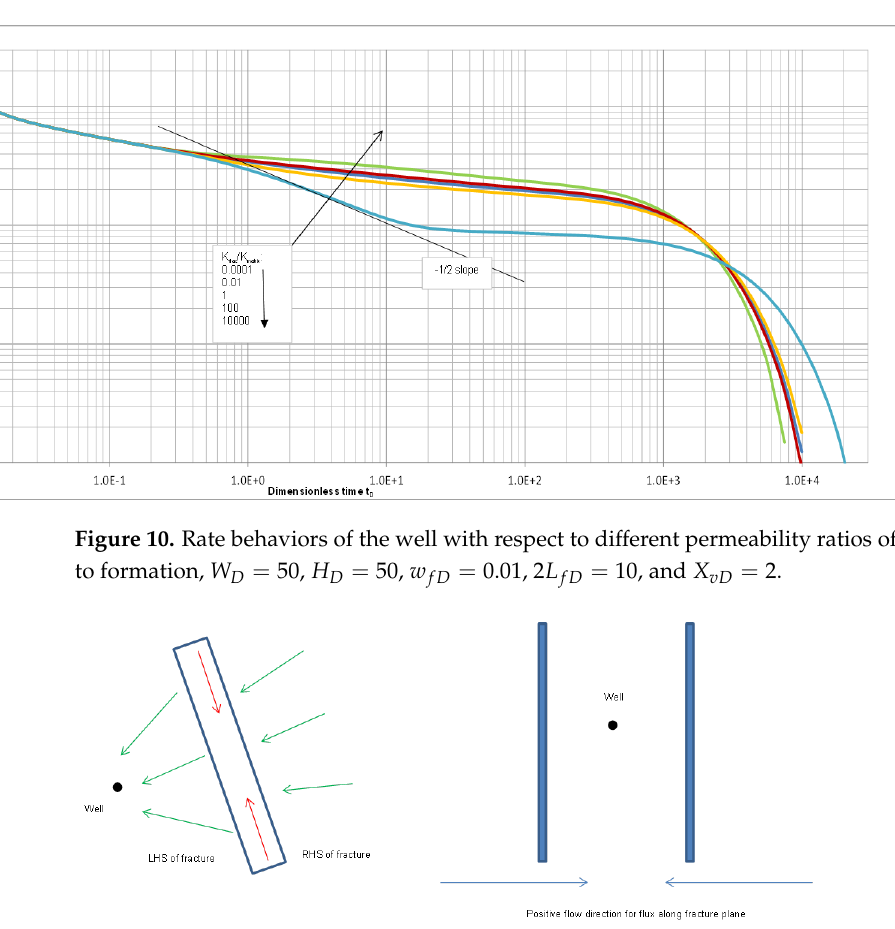
Figure 9. Pressure and its derivative behaviors of the well with respect to different permeability ratios of natural fracture to formation, 𝑊 𝐷 = 50 , 𝐻 𝐷 = 50 , 𝑤 𝑓𝐷 = 0.01 , 2𝐿 𝑓𝐷 = 10 , and 𝑋 𝑣𝐷 = 2 .